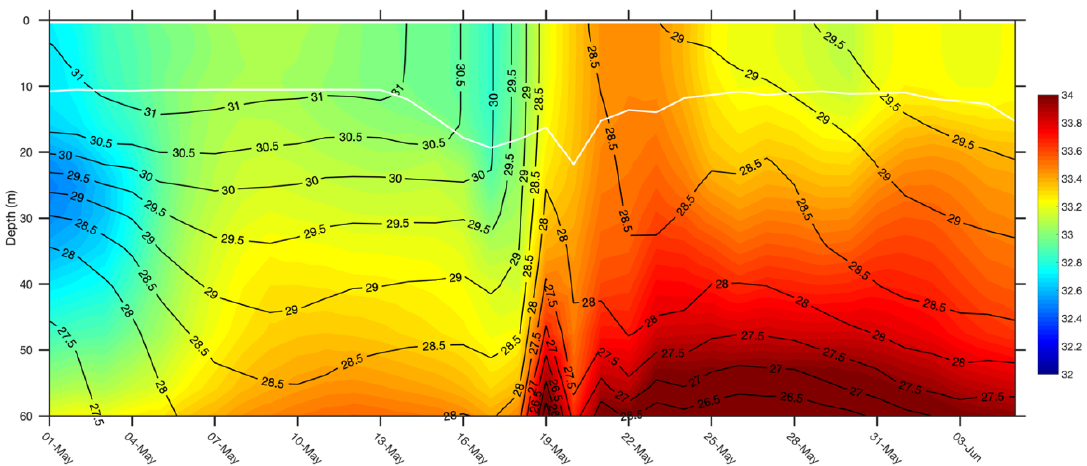
Figure 5. Box-averaged NEMO salinity (psu; shaded) overlaid with NEMO temperature contours (°C) and calculated mixed layer depth (m; white line) in the Bay of Bengal (86–88°E, 14°N) with depth